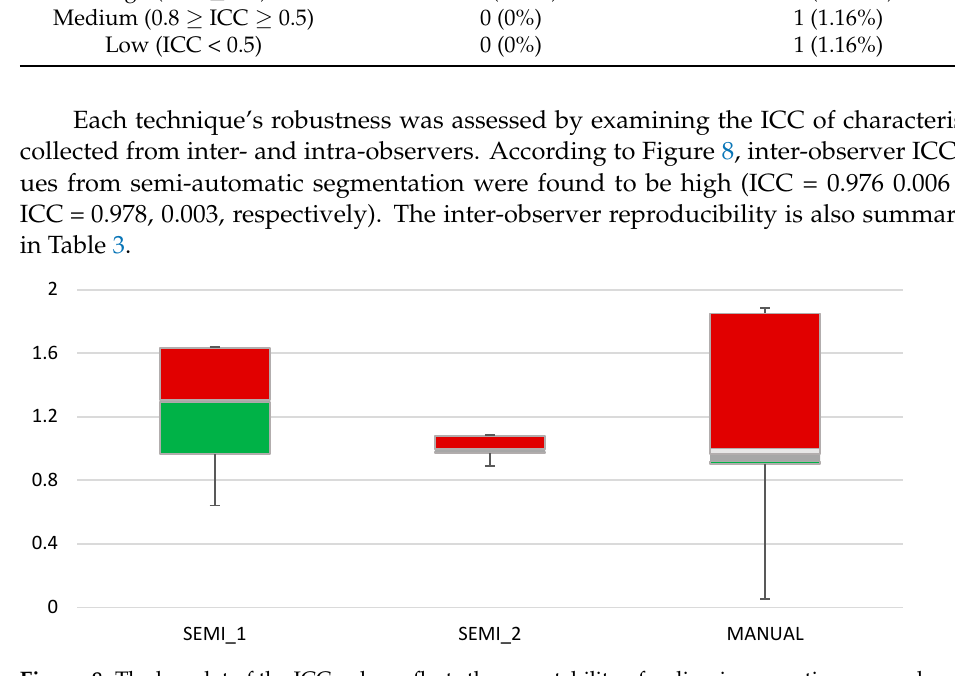
Table 2. The reproducibility groups in features extracted.